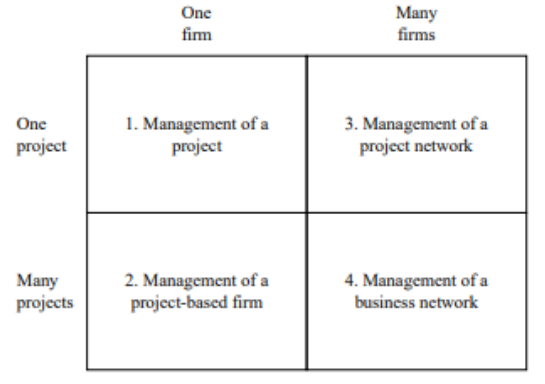
Figure 1. Framework for project